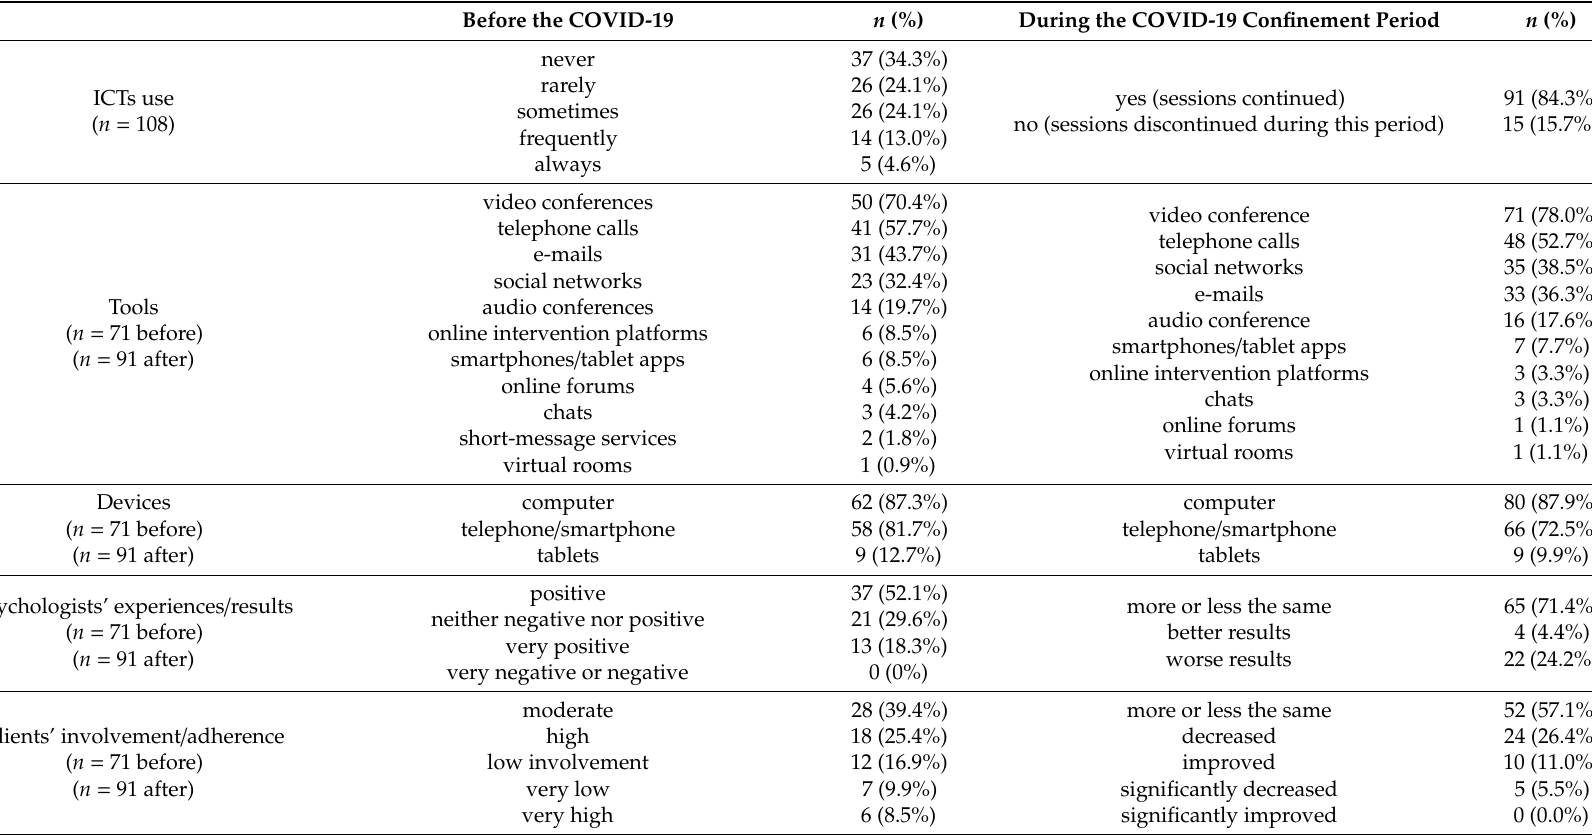
Table 2. Use of digital information and communication technologies in psychological counseling before and during the COVID-19 pandemic. Before the